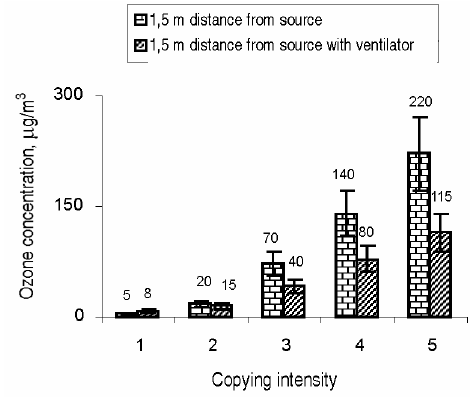
Fig 7. Horizontal distribution of ozone concentration at 1,5 m distance from source in ventilated room and unven- tilated room Ozone concentrations decreased significantly near and at a distance of 1,5 m from the source when copying machines were turned off, i e from 7:00 p m to 8:00 a m. Both measured ozone concentration values (in a venti- lated and unventilated room) fluctuated from 0 to 9 µ g/m 3 . The study results of horizontal ozone concen- tration scatter are provided in Table 2.